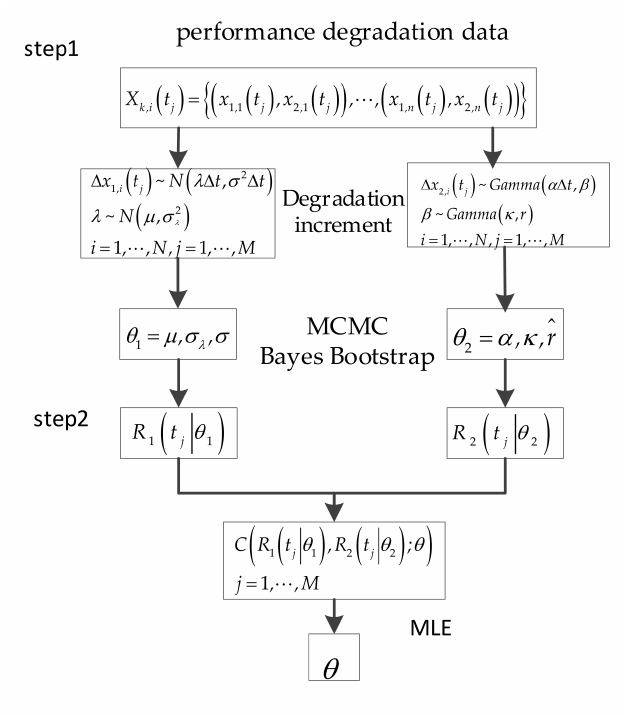
Figure 2. Two-stage estimation method